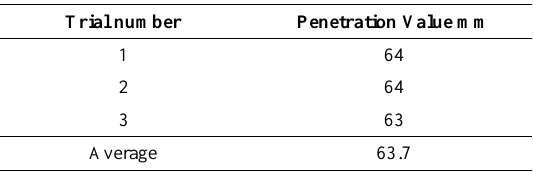
Table 5. Penetration test without polymer